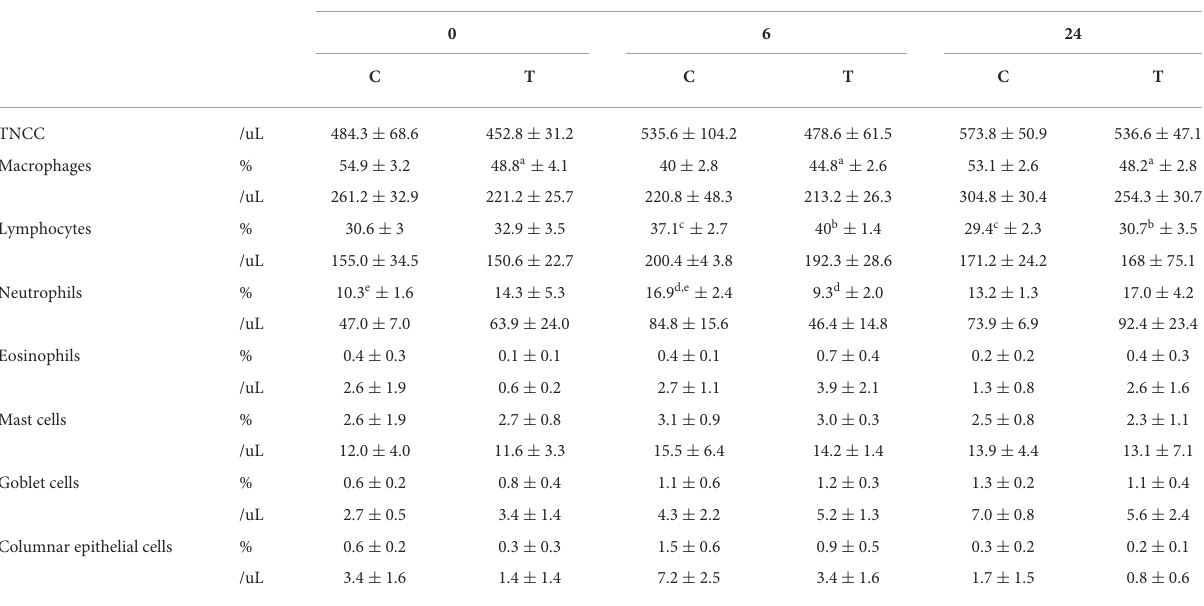
TABLE 1 Grouped BAL results from baseline ( t = 0h) to 24h post nebulization with either control substance (C) or G-CAPE (T), expressed as mean ± SE.